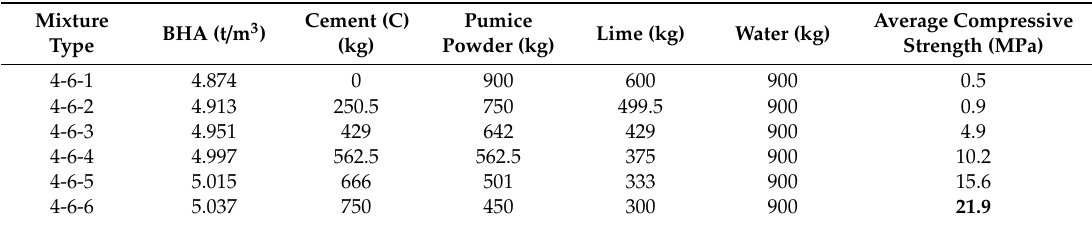
Table 30. Type-4-6 mixture quantity, weight per unit of volume and compression test